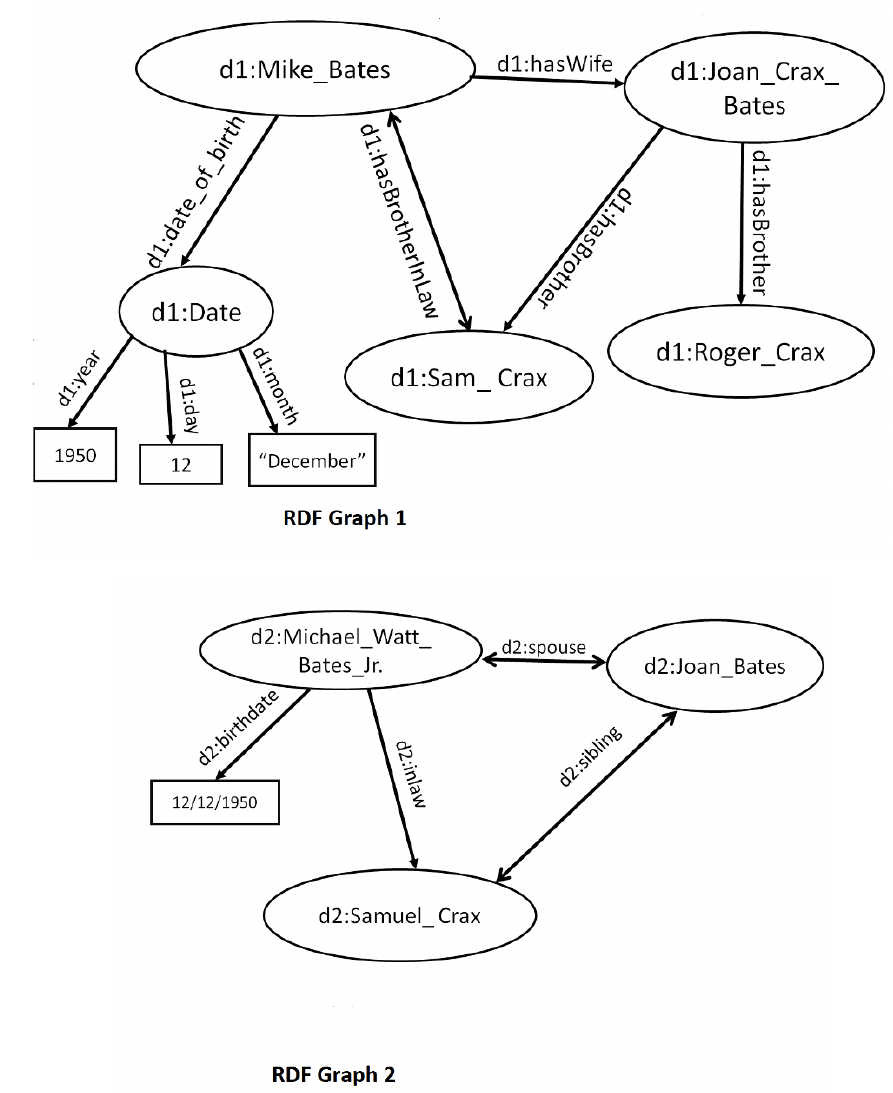
Figure 2. An instance of the Entity Resolution (ER) problem on two Resource Description Framework (RDF) knowledge graphs. In Semantic Web terminology, the ‘duplicate’ entities between the two graphs would need to be interlinked using a special property called owl:sameAs